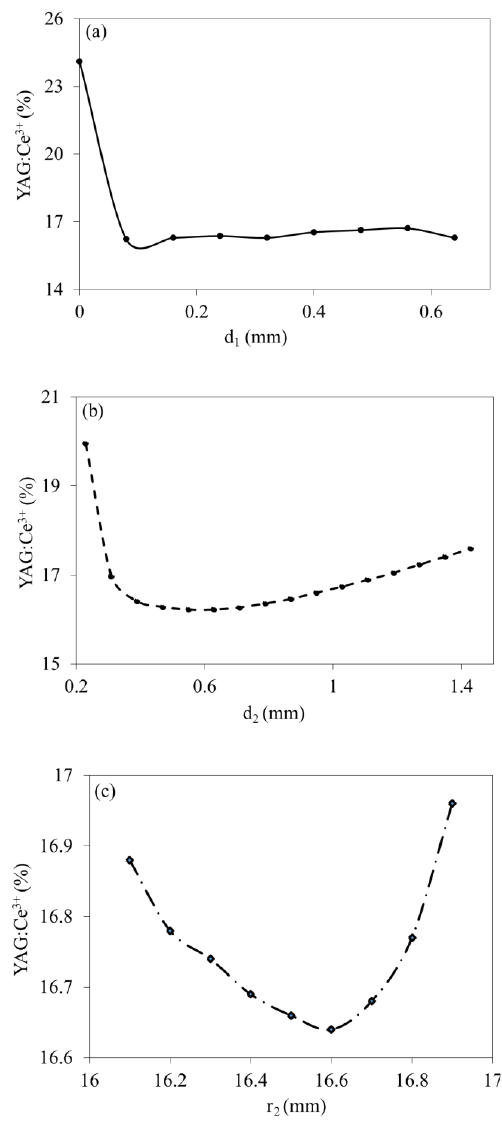
Fig. 4 illustrated the in(cid:29)uence of the gaps among the phosphor layers and the LED chip of inaccessible phosphor bundle on the transmit- ted luminous (cid:29)ux. Firstly, the luminous (cid:29)ux in Fig. 4 (a) relating to d 1 and in Fig. 4 (b) relat- ing to d 2 which tends to emphatically increase and reach the peak in the ranges of 0 to 0.08 mm and 0.23 mm to 0.63 mm respectively. For FDRP con(cid:28)guration, the luminous (cid:29)ux is max- imum at 1020 lm when d 1 = 0.08 mm or d 2